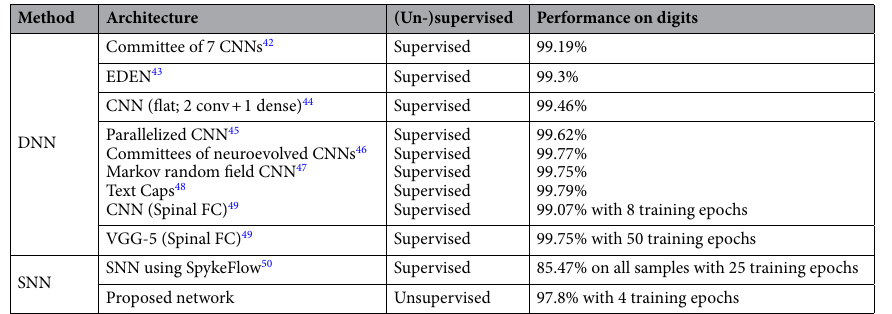
Table 1. The performance of the best published studies in recognition digits of